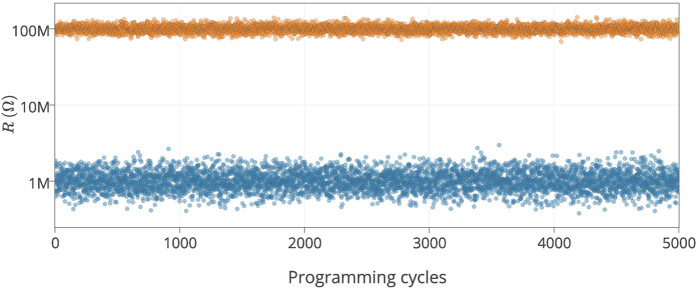
Cycle to Cycle (C2C) variations.ROFF and RON variation of an individual memristor for 5000 cycles, experimental data is adopted from24.